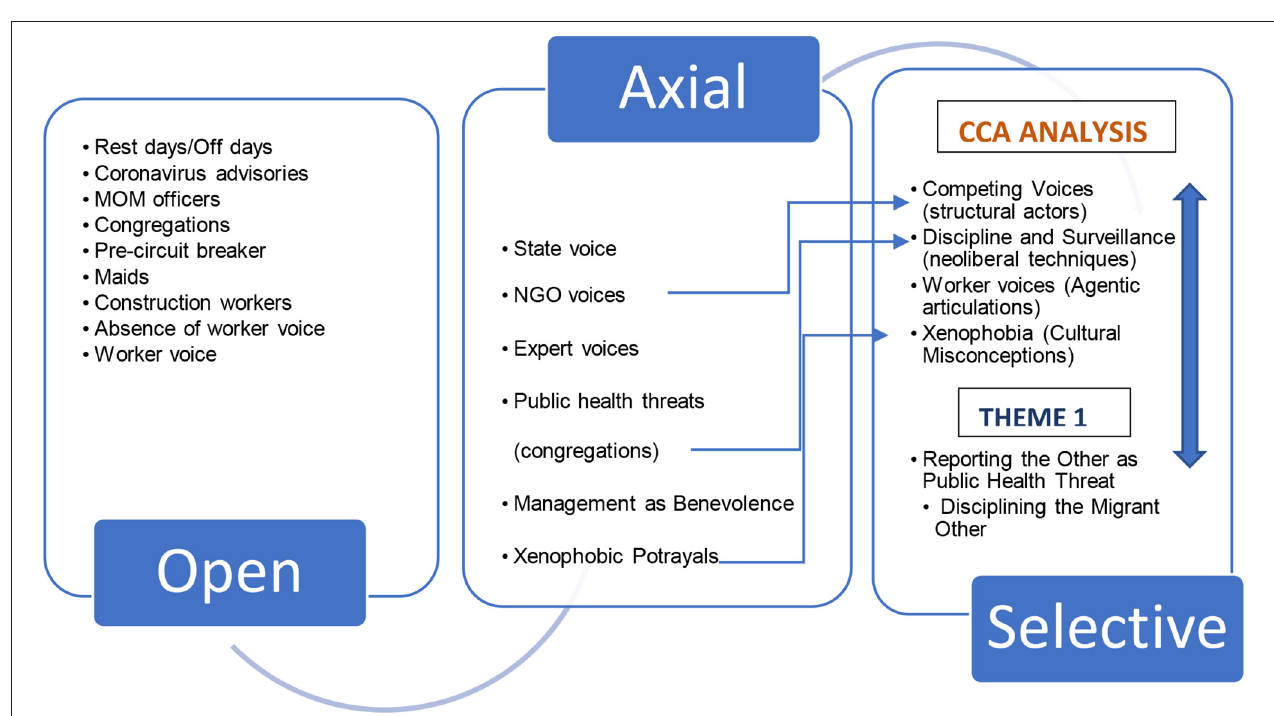
FIGURE A1 | Illustration of coding process.